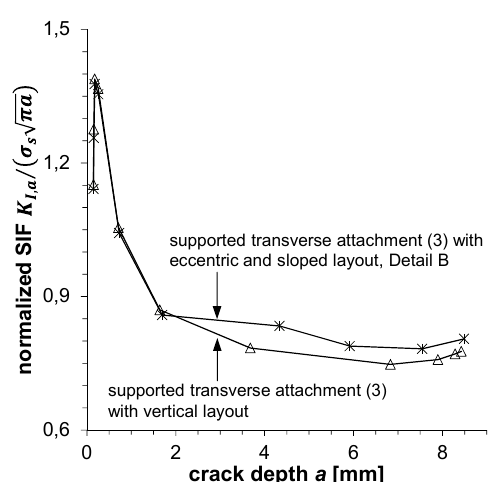
Figure 9: Influence of slope and weld flank angle on fatigue life, shown for selected variants for equal  eff .